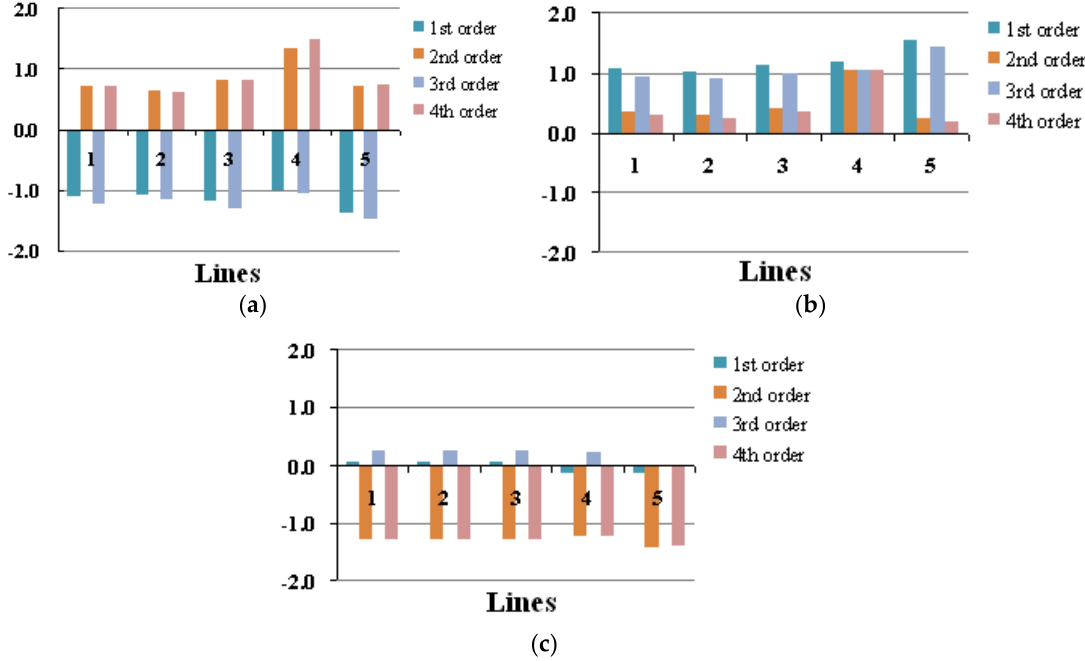
Figure 6. Current distributions of each order for the SLGF on different five lines by using the SMs. ( a ) Phase A; ( b ) Phase B; and ( c ) Phase C.